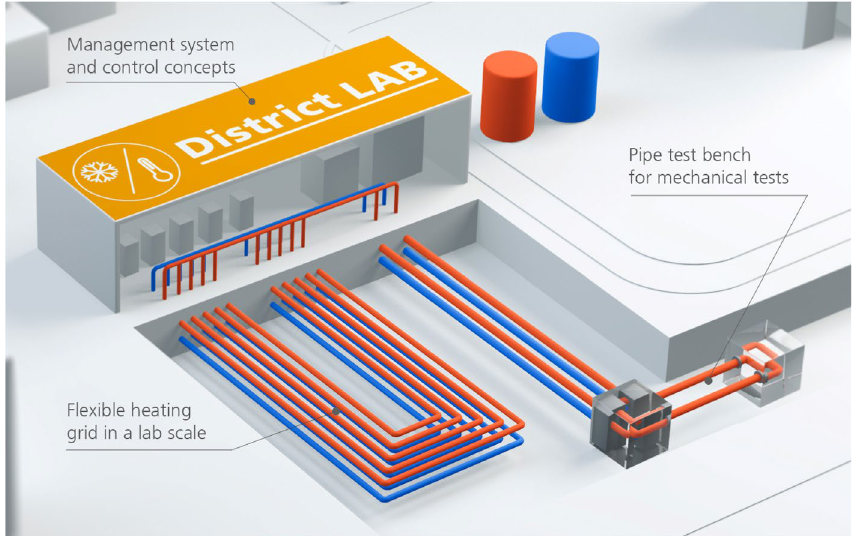
Fig. 1 Schematic representation of the structure of planned test facility D-LAB (Fraunhofer Institute for Energy Economics and Energy System Technology (IEE)